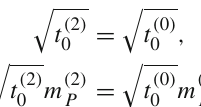
Table 7 Meson decay constants in t 0 units. For N f = 2 simulations, the first line contains the values extrapolated to the tuning point μ (cid:2) and the second line the values at the simulated parameters. For N f = 0 ensembles, the first line gives the values interpolated to μ (cid:2) , and the